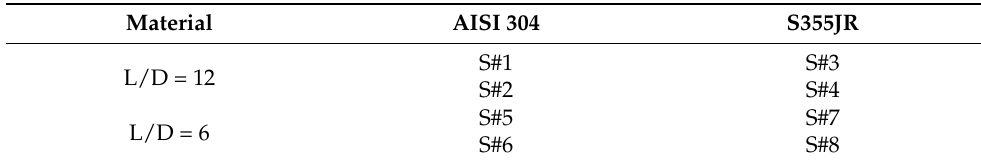
Figure 1. The view of the shafts with length/diameter (L/D) ratios of 6 ( a ) and 12 ( b ) during machining. Table 1. Designation of samples under